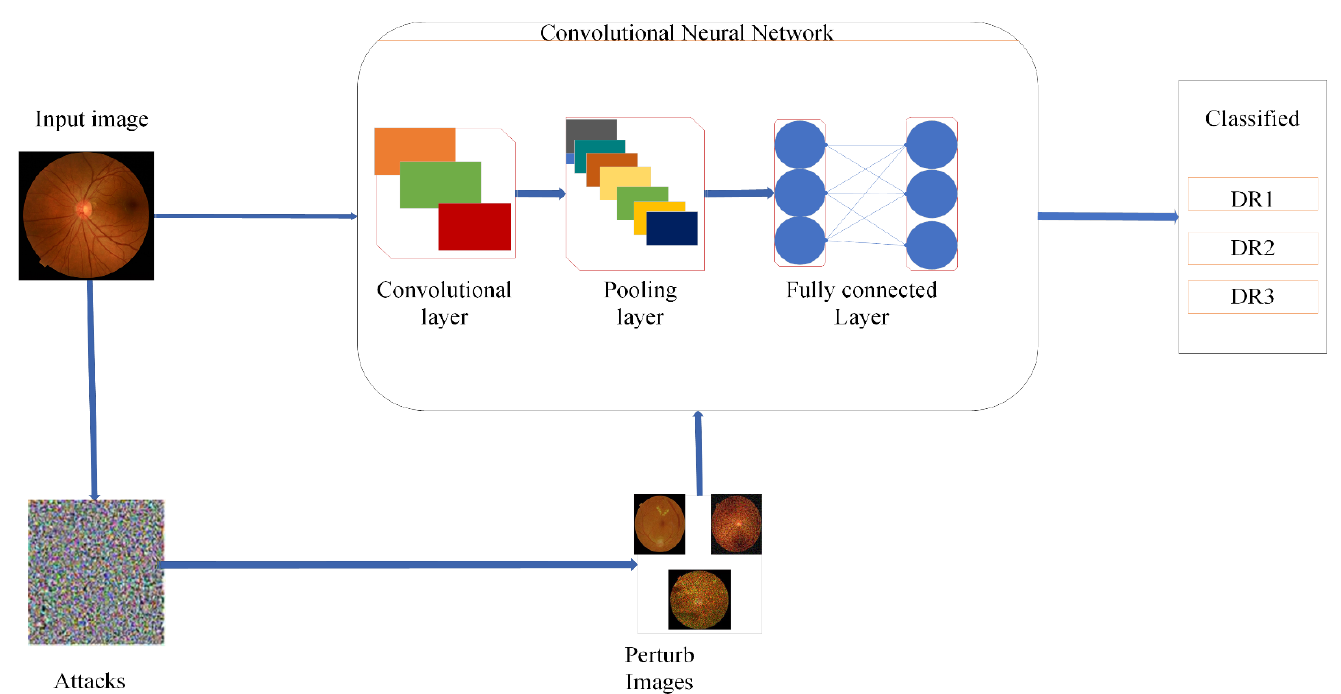
Figure 5. Illustration of the adversarial training